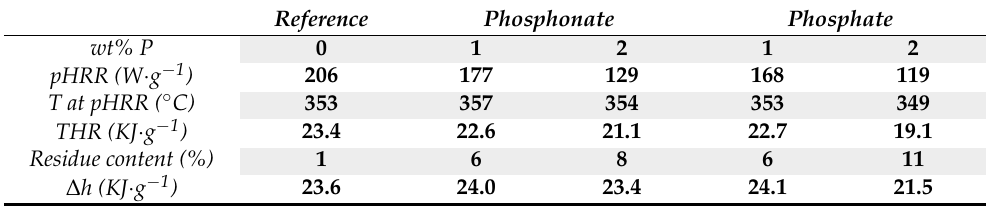
Table 4. Results of PCFC analyses of reference EC alkyd resin and PO x CR diluent EC alkyd